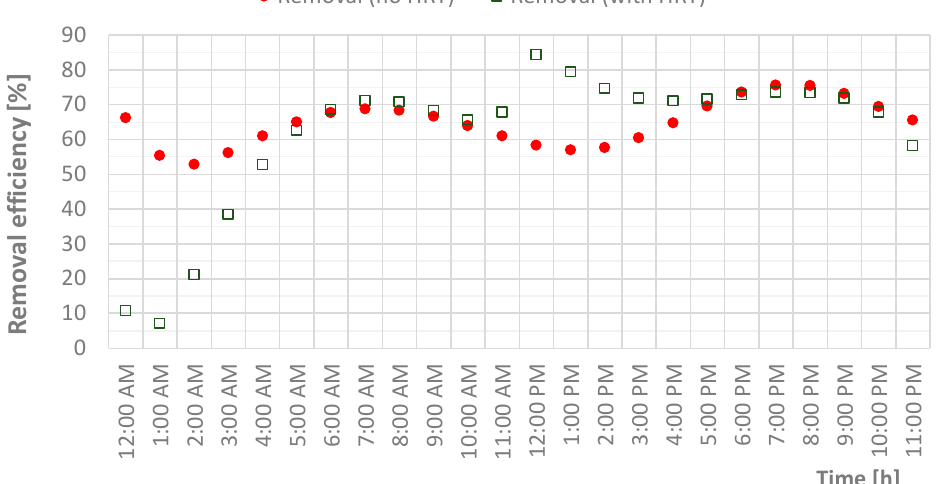
Figure 7. Evaluated removal efficiency of the RV_Sub on the basis of single grab samples taken at the influent and effluent at the same time (colored circle) and considering the hydraulic retention time (HRT) of the treatment step (void square).